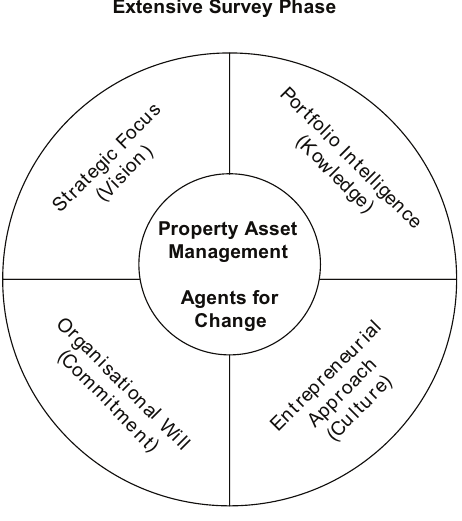
figure 5. asset management key change